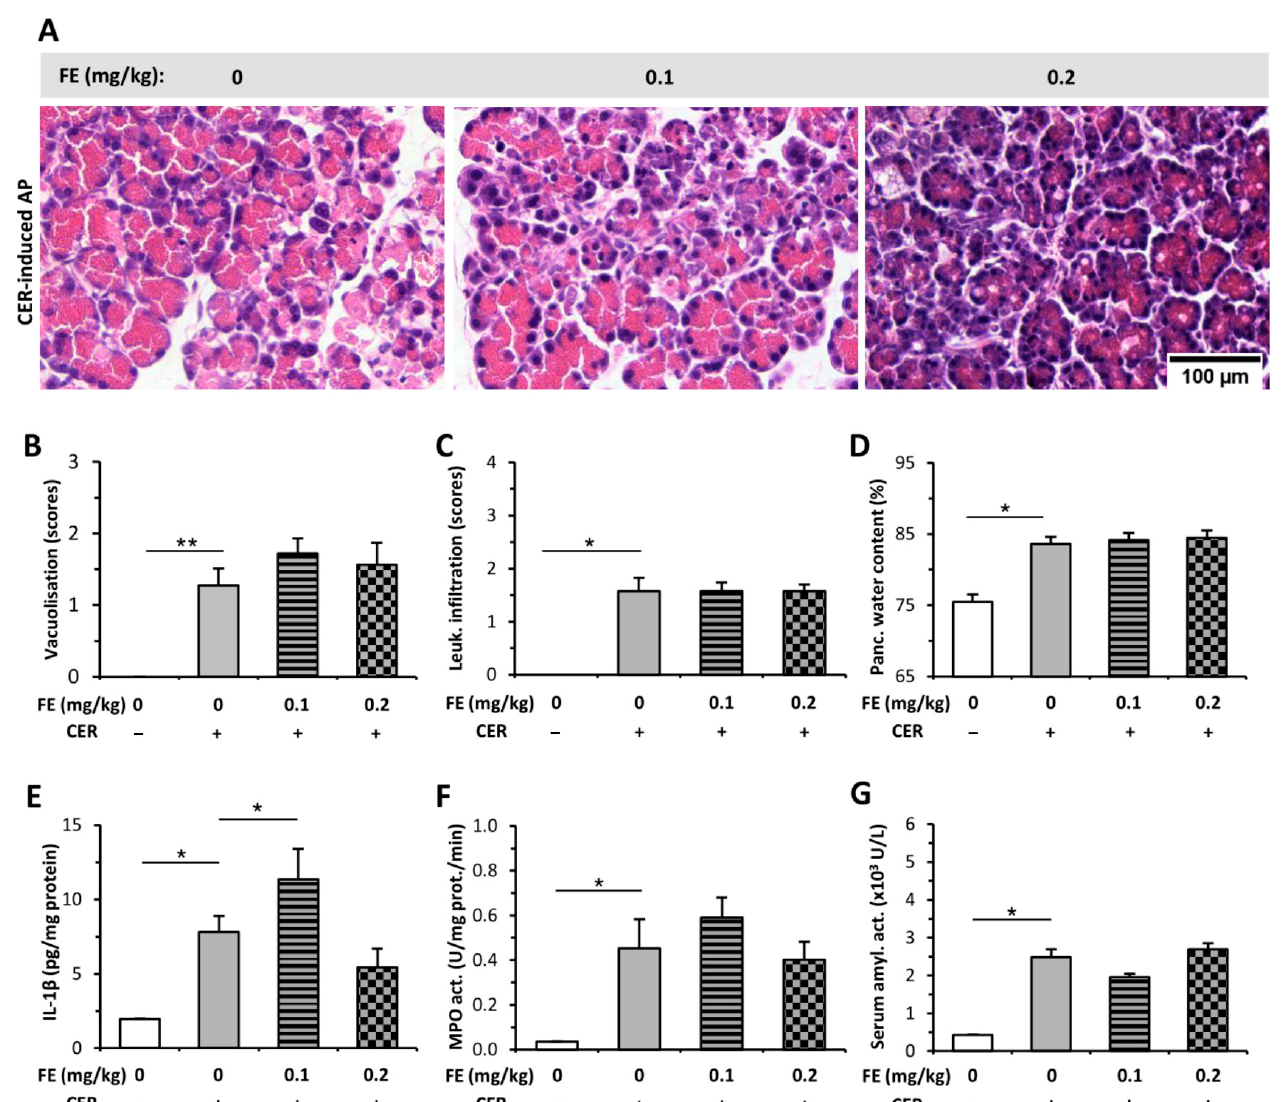
Figure 5. Fentanyl (FE) treatment started after the induction of acute pancreatitis (AP) with cerulein (CER) does not affect disease severity. ( A ) Representative histopathological images of pancreatic tissues of the treatment groups. Bar charts show the extent of pancreatic ( B ) vacuolization, ( C ) leukocyte infiltration, ( D ) water content, ( E ) interleukin-1 β (IL-1 β ) concentration, ( F ) myeloperoxidase (MPO) activity, and ( G ) serum amylase activity measurements. Values represent mean with standard error, n = 6. Two-way ANOVA was performed followed by the Holm–Sidak post hoc test. * p < 0.05; ** p <